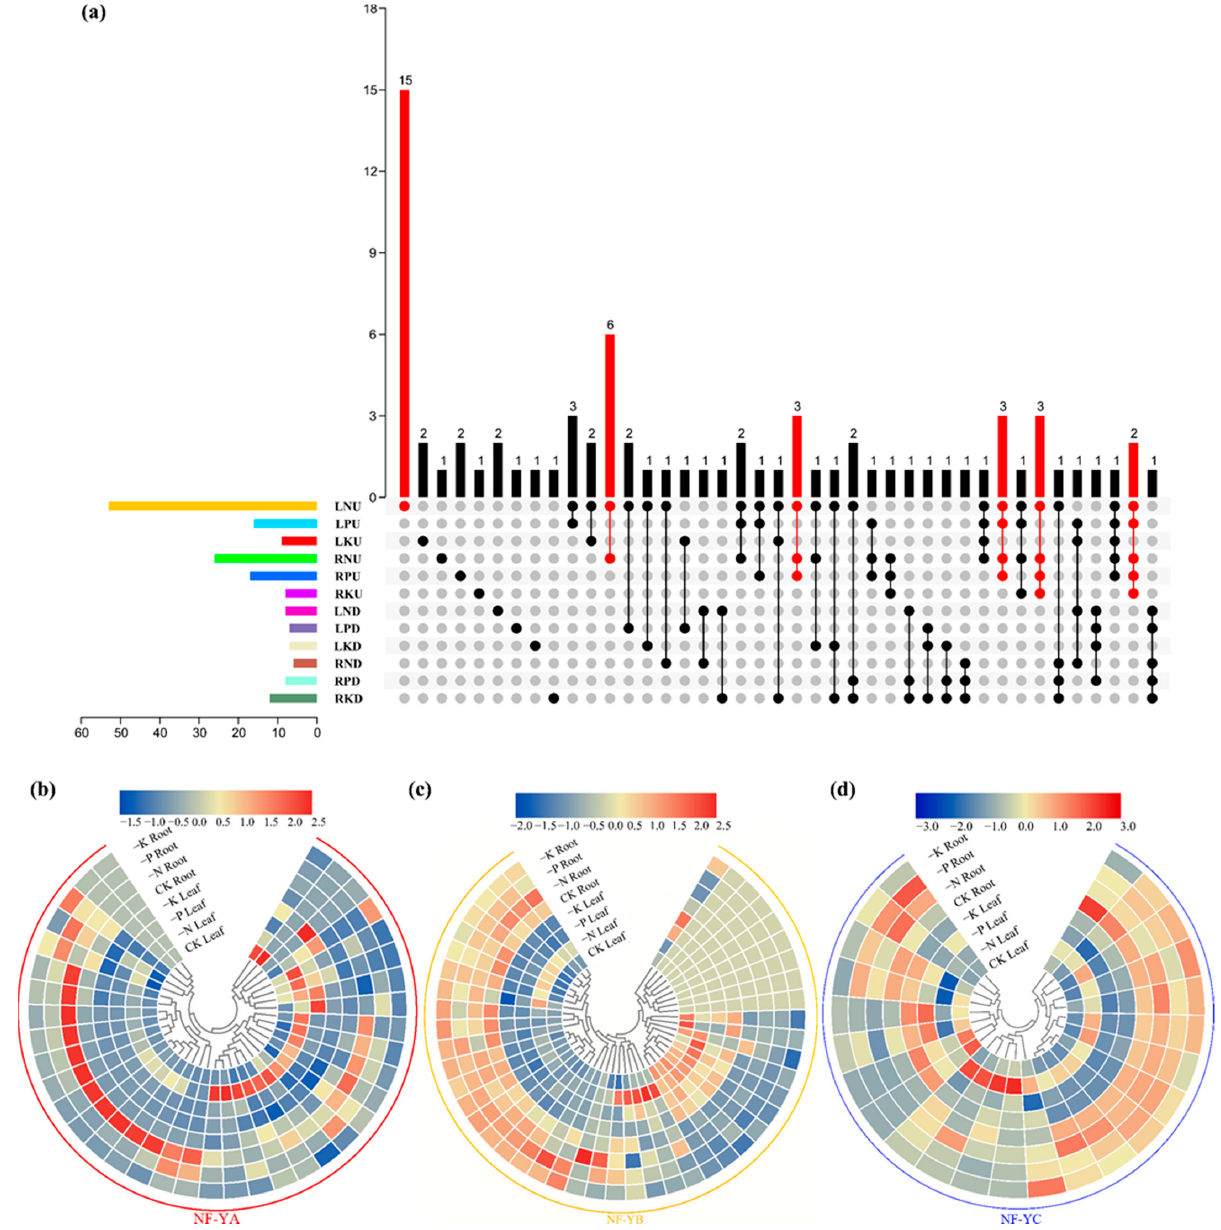
Figure 7. Expression profiles of each NF-Y subfamily in rapeseed leaf and root under three nutrient deficient conditions. Seedlings 14 days old were cultivated under nitrogen, phosphorus and potassium deficient environments, respectively, for 6 days. The fully expanded leaf and root were harvested separately for RNA extraction. ( a ) Upset plot of significantly regulated genes under different treatments in two tissues. The red column represents the treatment with the highest num- ber of genes in the same number of crosses; ( b ) The BnaNF-YA subfamily; ( c ) The BnaNF-YB subfamily; ( d ) The BnaNF-YC subfamily. The color scale is shown above each subfamily. The data in the heat map was normalized (z-scores) using FPKM values and then generated by Tbtools; the higher the value of the color scale, the higher the expression, and vice versa. − N: nitrogen de fi ciency; − P: phosphorus de fi ciency; − K: potassium de fi ciency; CK: su ffi cient nutrient supply. L: leaf; R: root; N: nitrogen deficiency; P: phosphorus deficiency; K: potassium deficiency. D: downregulated; U: upregulated.